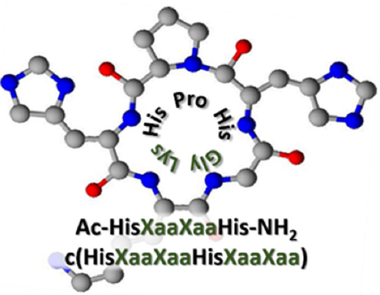
Figure 3. The competition plot between L1 − c(GlyHisProHisLys) and L2 − c(GlyHisGlyHisLys) in the presence of Cu(II) ions under the equimolar conditions.